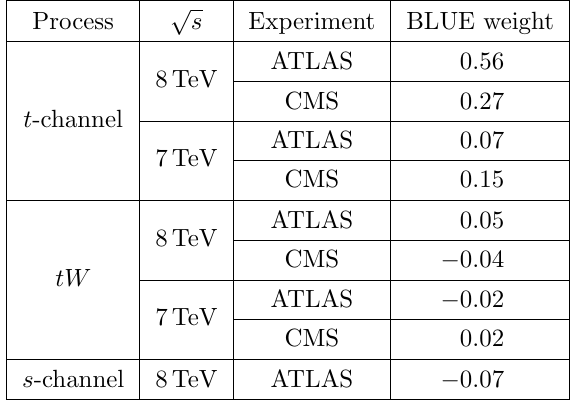
Table 8 . BLUE weights for the overall